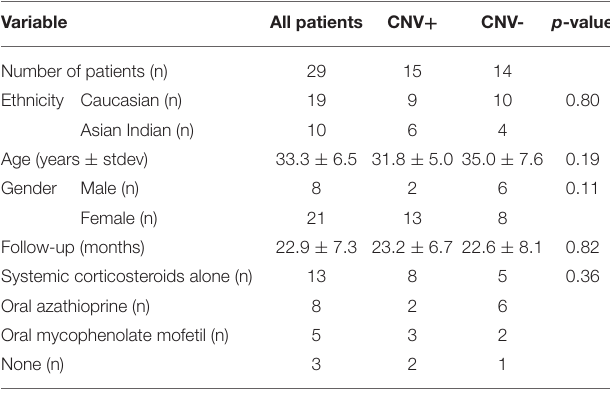
TABLE 1 | Demographic and clinical characteristics of patients with punctate inner choroidopathy (PIC) included in the study. Variable